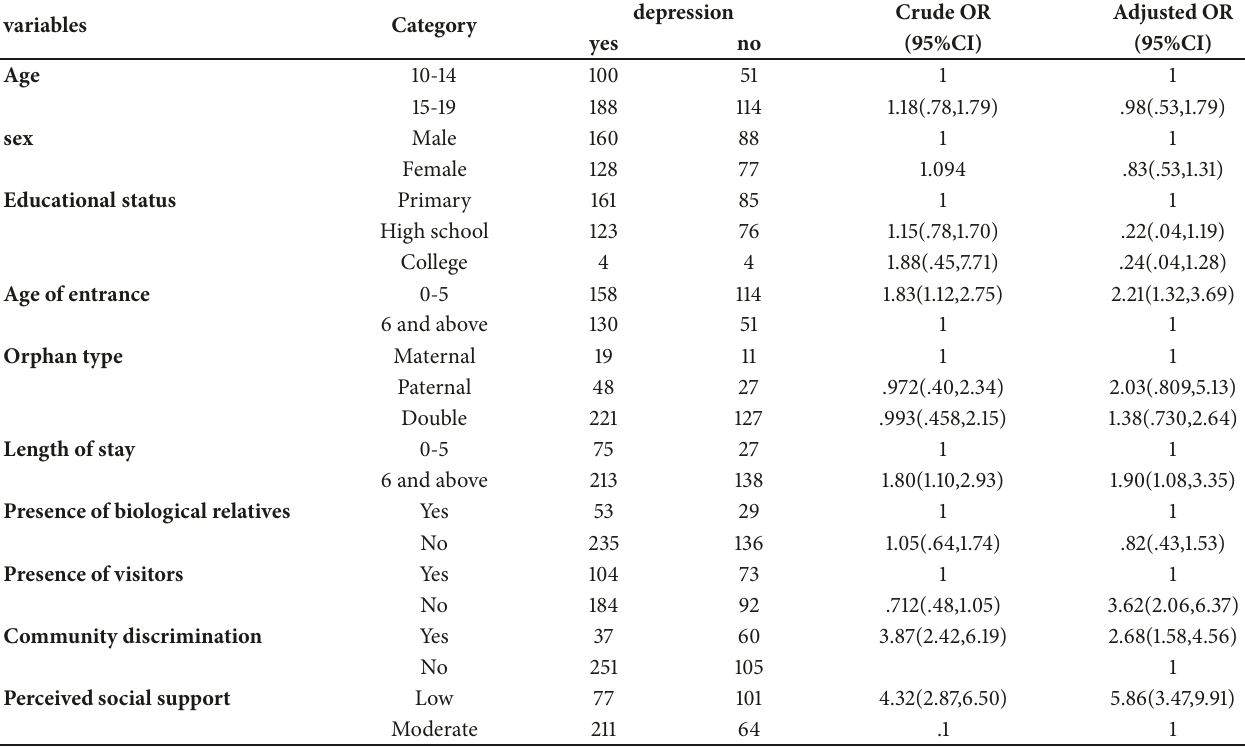
Table 3: A multivariable logistic regression of associated factors with depression among orphan adolescents in Addis Ababa, Ethiopia, Jul 2016